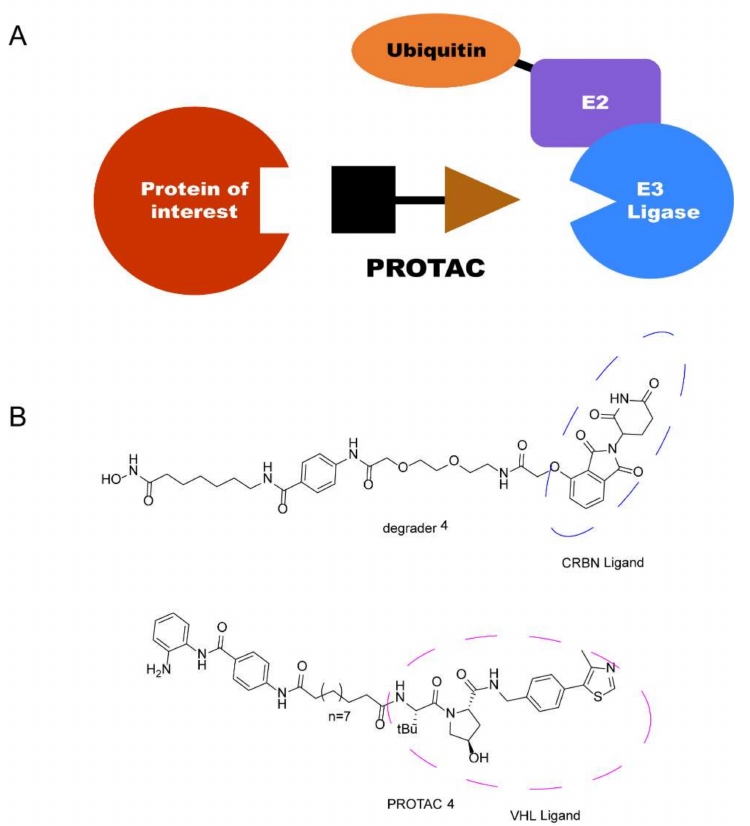
Figure 2. ( A ) General diagram of PROTAC. ( B ) Representative HDAC PROTACs with CRBN and VHL as E3 ligases.